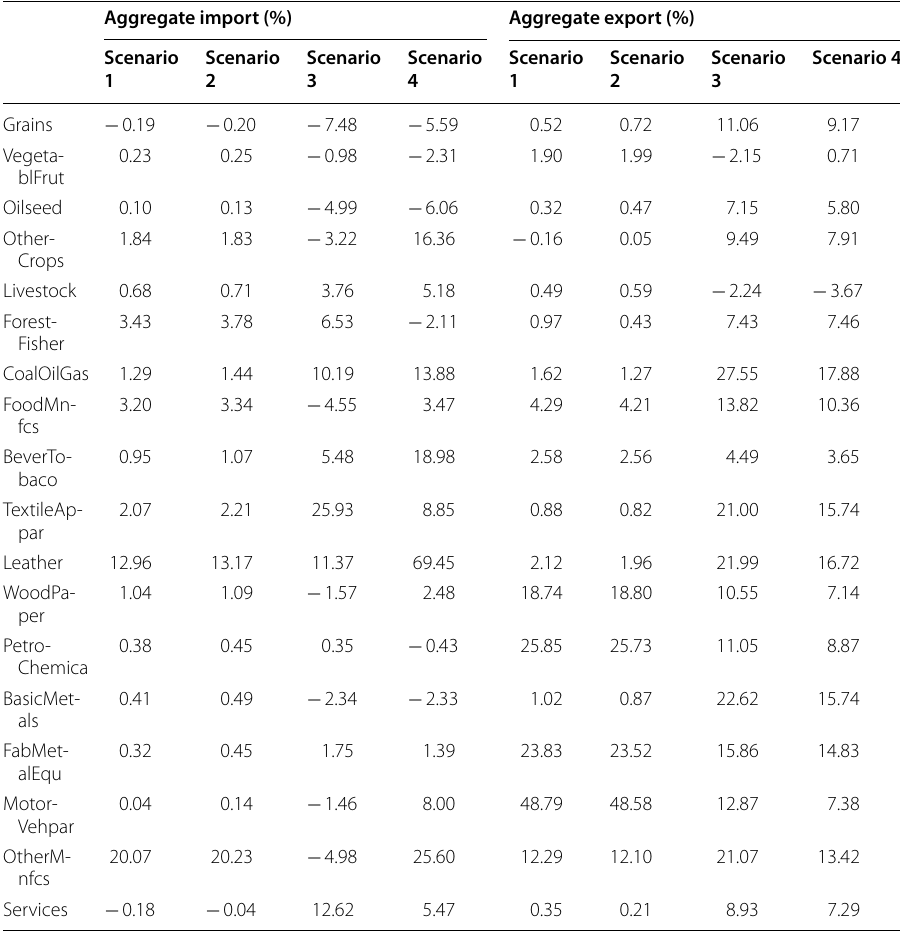
Table 11 Changes in aggregate export and import for Ethiopia. Source: Model